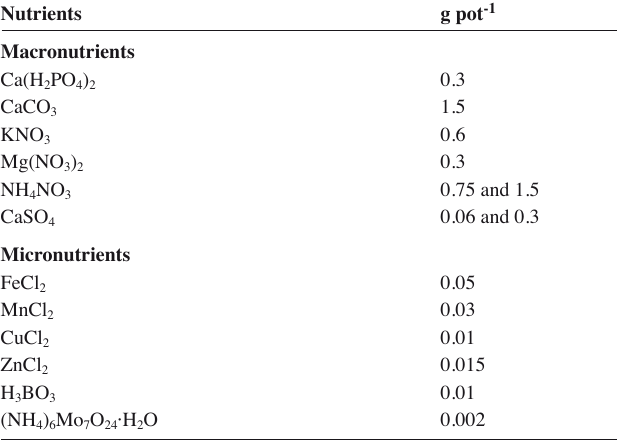
Tab. 1: The compositions of the nutrient solution (g pot -1 )